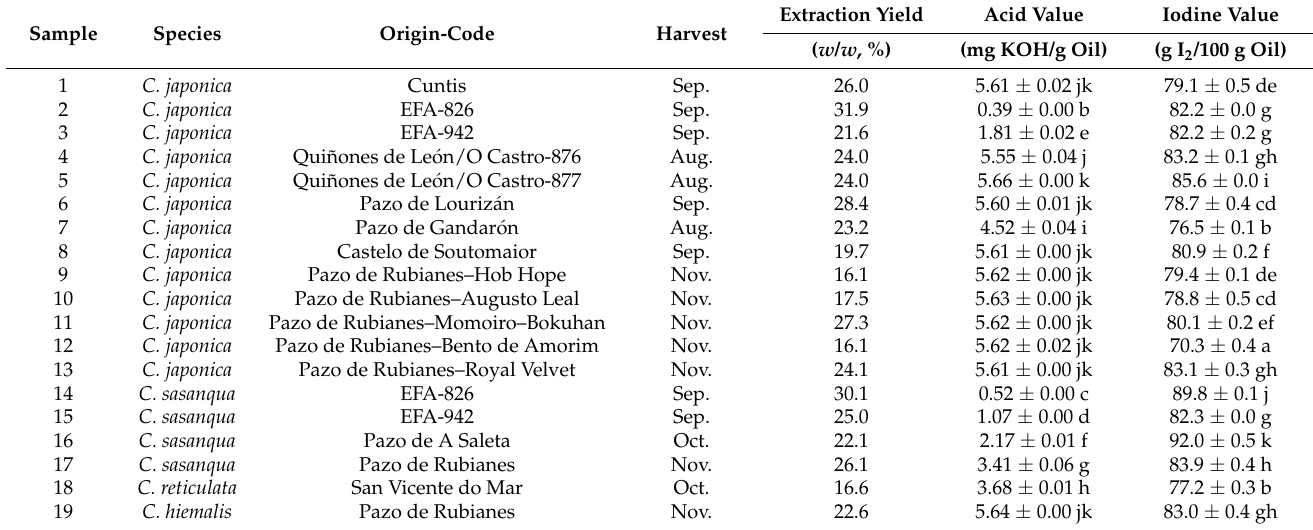
Table 1. Origin and quality parameters of Camellia seed